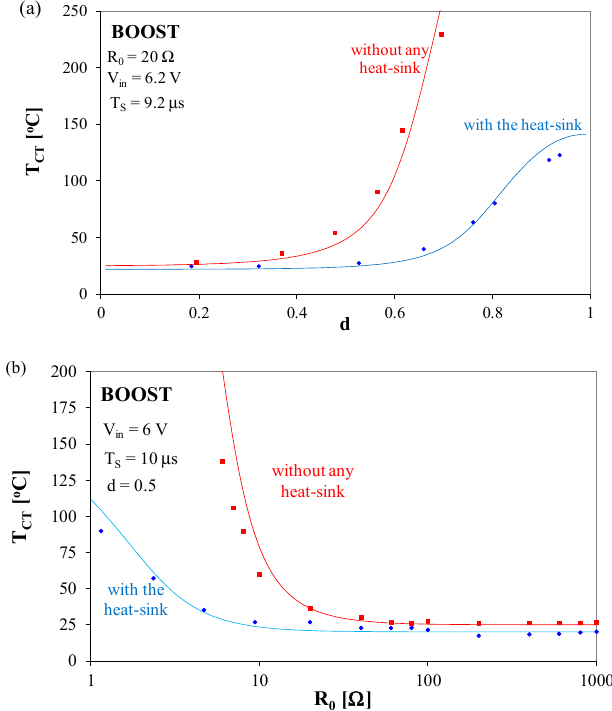
Figure 5. Dependences of the case temperature of the transistor contained in the boost converter on: ( a ) the duty cycle d, ( b ) on load resistance.